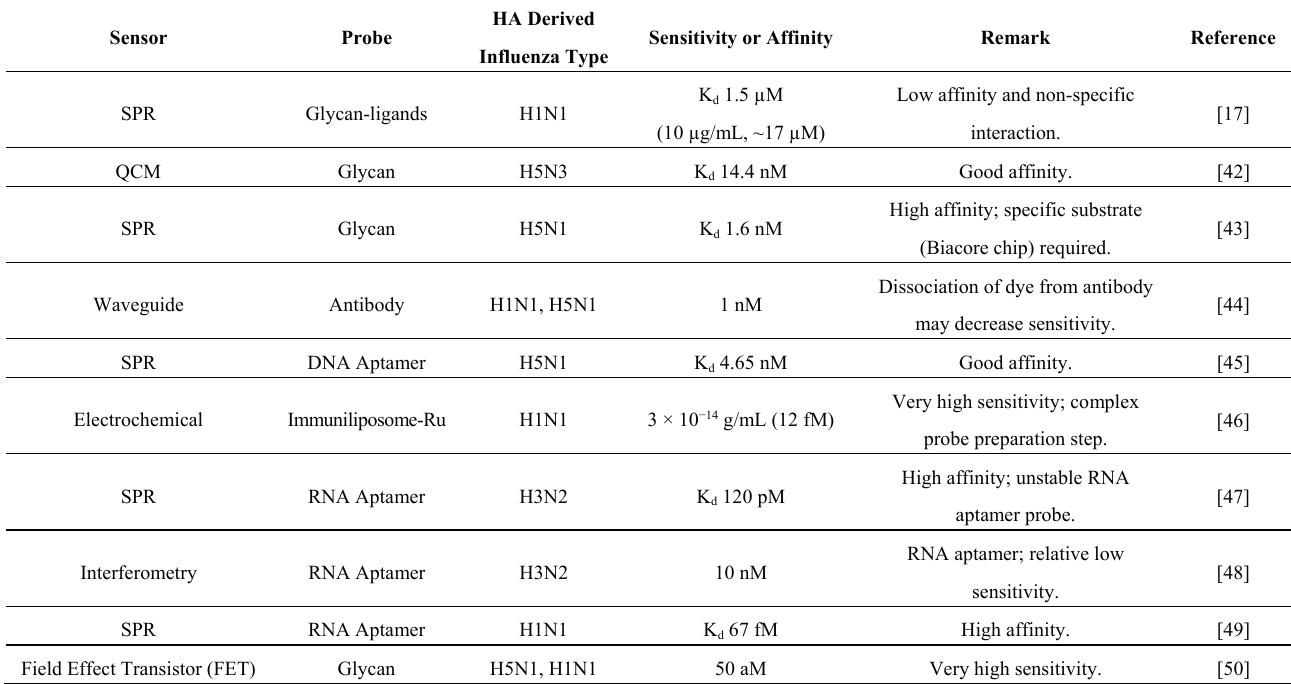
Table 1. Comparison of the sensitivity of the developed biosensors for the detection of influenza